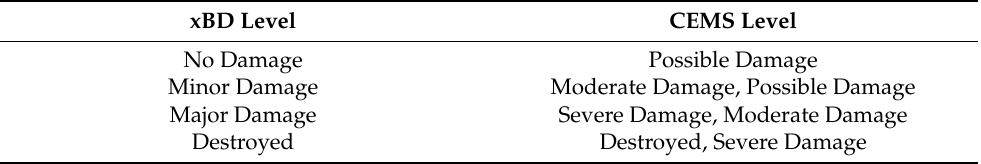
Table 2. Level of correspondence between xBD and Copernicus Emergency Management Service (CEMS). Table 3. The two disasters’ detail information.